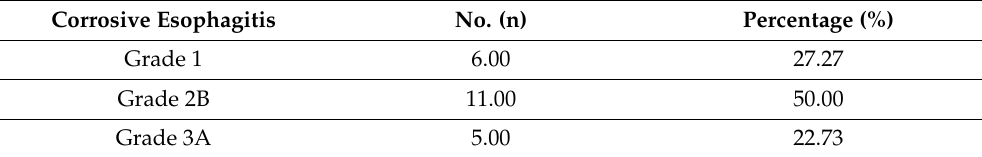
Table 2. Endoscopic